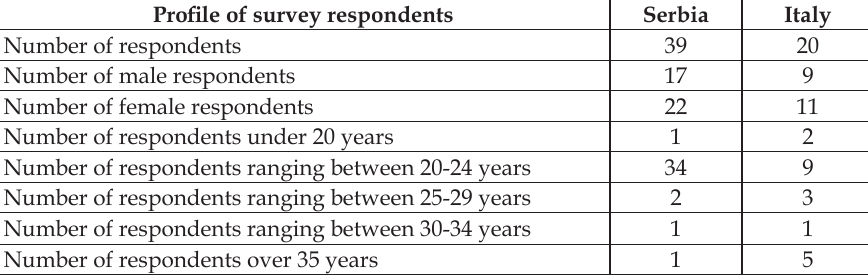
Table 1. Pro  le of survey